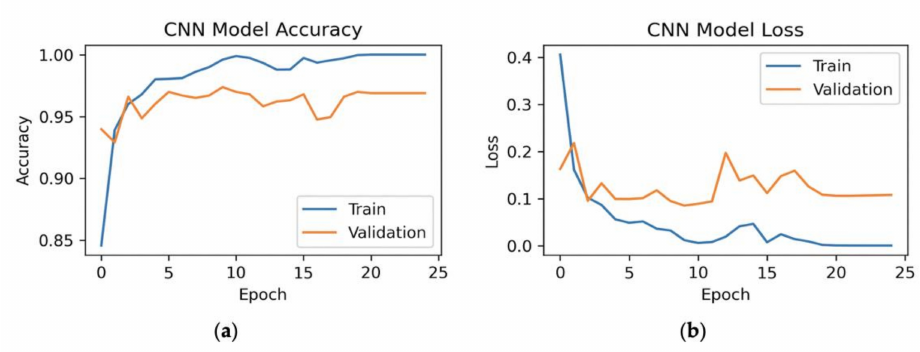
Figure 17. Experimental results for 138 features: ( a ) epoch vs. accuracy and ( b ) epoch vs. loss. Finally, we have done the experiment for CNN with 200 principal components, where we have obtained the 164 most important features of the dataset for the model. The experi- mental results are shown in Figure 18.